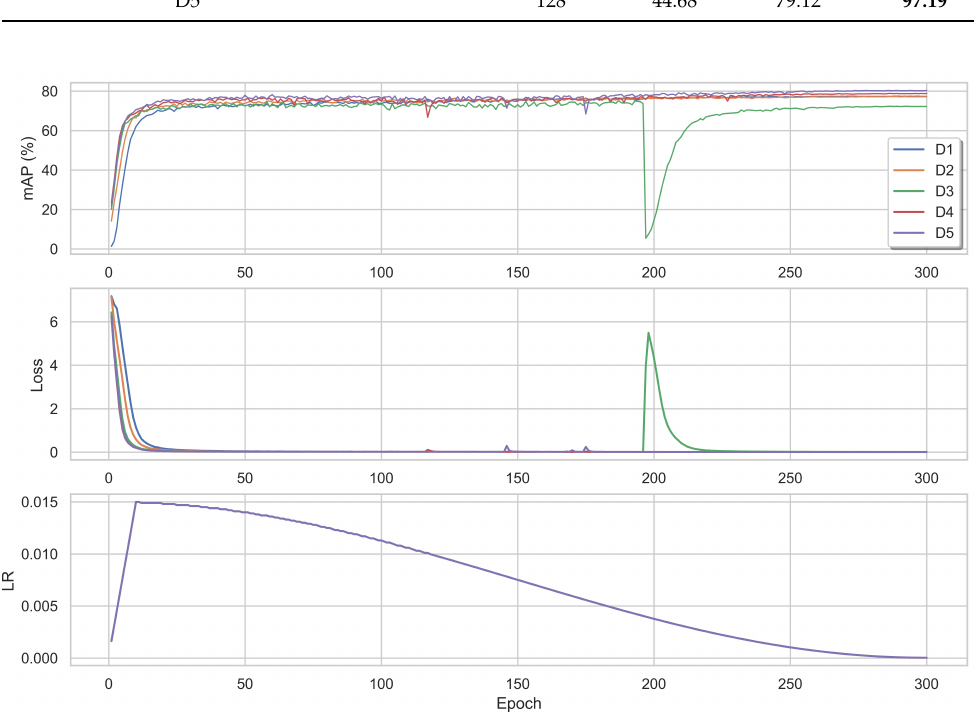
Figure 13. The mAP scores and training loss per epoch for different variants using BNNeck and a base learning rate of 0.0150. The bottom figure shows how the learning rate decays per epoch using the cosine